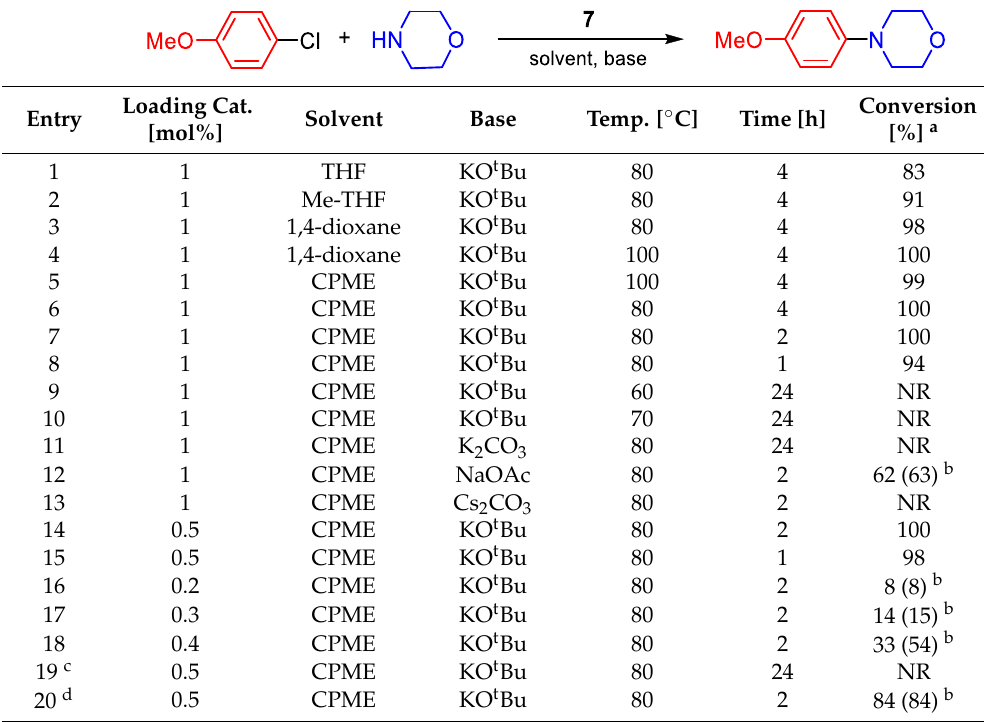
Table 2. Buchwald–Hartwig amination; selection of optimal conditions. Table 2. Buchwald – Hartwig amination; selection of optimal